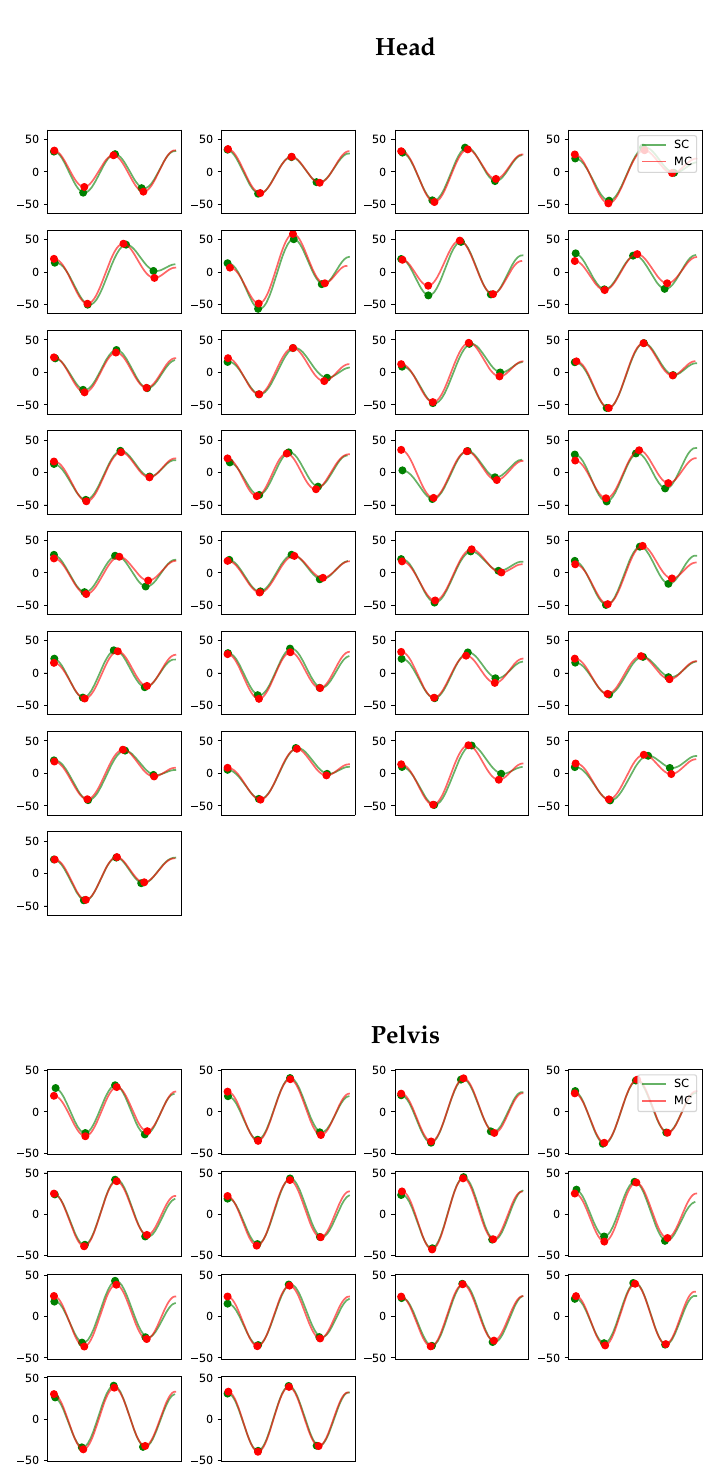
Figure A14. Vertical displacement signals per stride for the head and pelvis for horse 15. Each subplot contains the matched stride segments for the single-camera markerless system (SC) in green and the multi-camera marker-based system (MC) in red. The y-axis shows the vertical displacement in millimeters. The four dots on each curve indicate the positions of the two peaks and two valleys extracted using the approach in Section